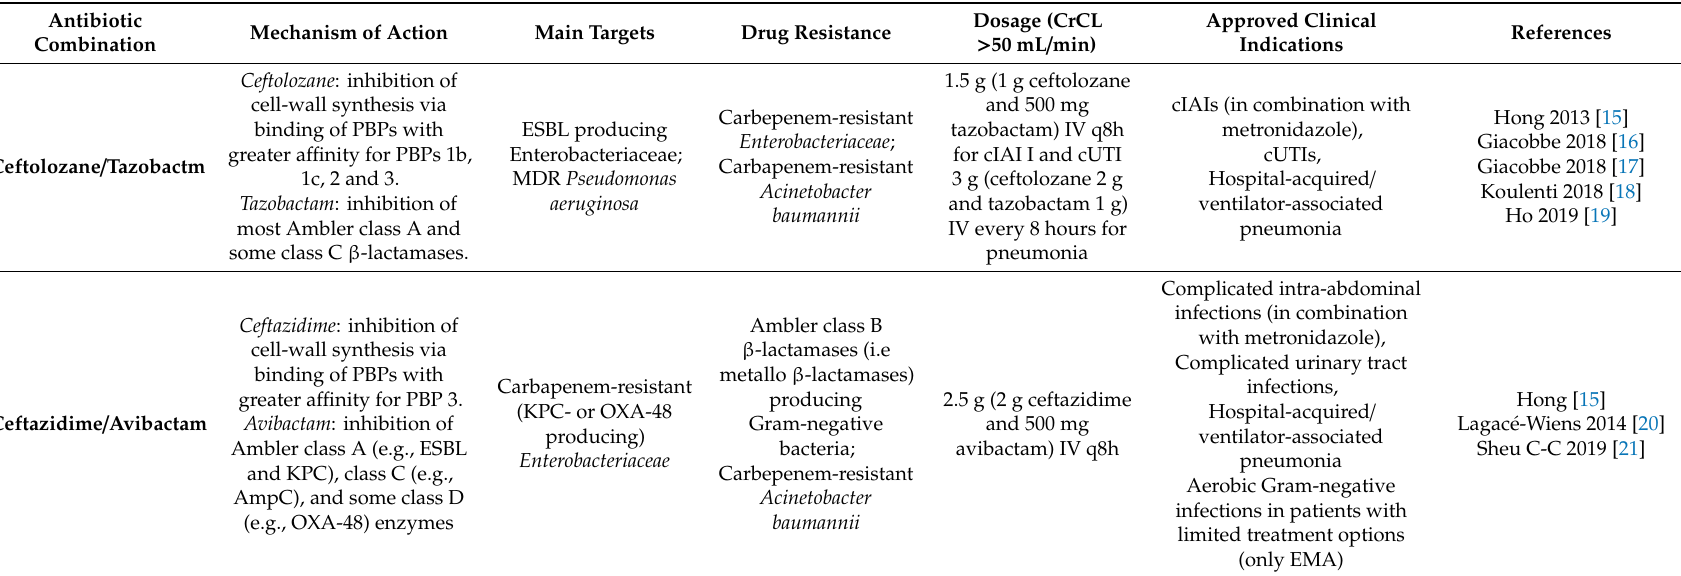
Table 1. Main characteristics of ceftazidime / avibactam and ceftolozane /